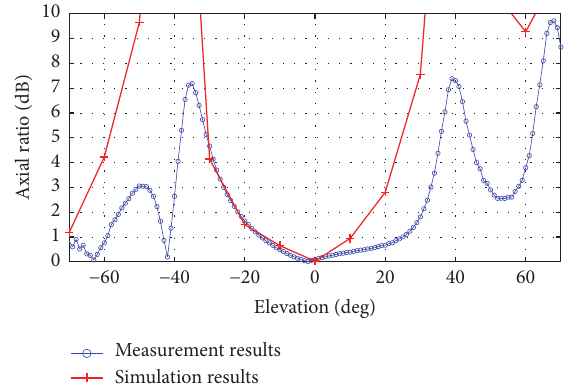
Figure 10: V plane AR as function of elevation angle at 922.5 MHz.